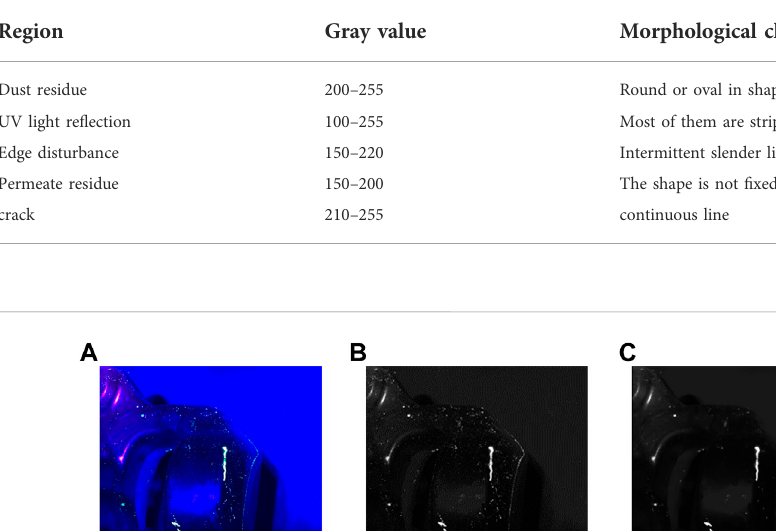
TABLE 1 Gray value and morphological characteristics of images in different